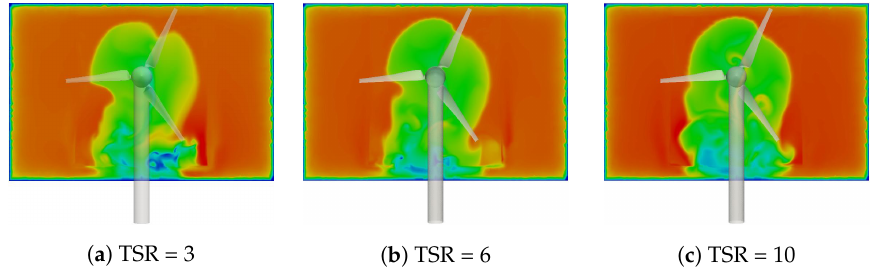
Figure 16. HAWT S826: Velocity magnitude exhibiting the wake distribution at TSR values of 3, 6, 10. Note: the velocity magnitude is restricted to 0–1 m/s to provide better